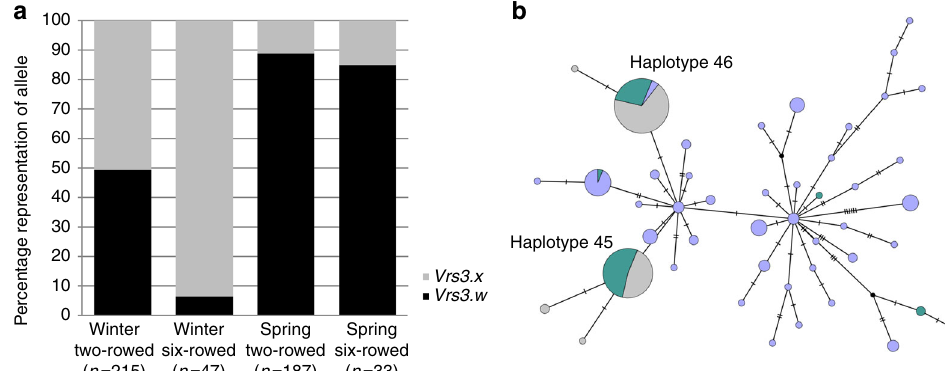
Fig. 3 The allelic diversity of VRS3 across wild, landrace and cultivated barley germplasm. a Frequency of Vrs3 .w and Vrs3 .x alleles across the major classi fi cation divisions (winter-sown, spring-sown, two-rowed and six-rowed) within cultivated barley. b Median joining network illustrating the occurrence and relationships between different Vrs3 haplotypes across wild species (purple), two-rowed landrace (green) and six-rowed landrace (grey) germplasm. Tick marks across the connecting bars represent the number of polymorphisms distinguishing haplotype groups. The size of the circle is proportional to the number of representatives within the allelic class. Vrs3 .w and Vrs3 .x are renamed haplotype 45 and 46 because three SNPs at the 5 ′ and 3 ′ end of the exome capture alignments were missing from the